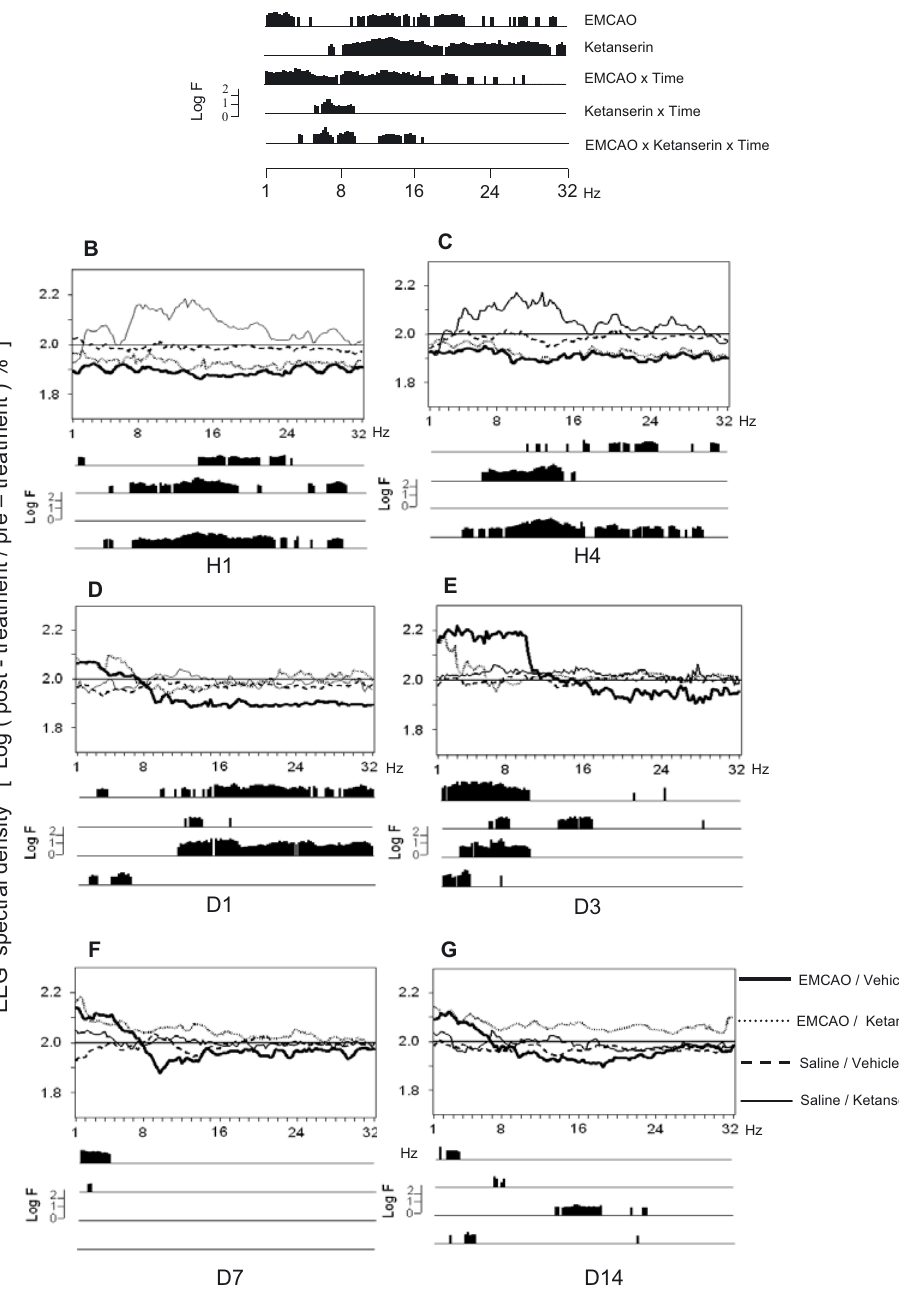
Figure 1. Effects of intracerebral injection of ET1 (60 pmol) in the vicinity of left MCA in conscious rats on the EEG power spectra in the left somatosensory cortex, forelimb region (SIFL) during quite waking and the effects of ketanserin (6 mg/kg i.p.) administered 20 min after ET1. At A – MANOVA results for each 0.25 Hz-bin of the power spectra from 1 to 32 Hz expressed as log Fisher (F)-values (vertical lines). Only frequency bins where the main effects of factor “EMCAO”, factor “Ketanserin” and their interactions with factor “Time” were significant at P < 0.05 were depicted. At B, C, D, E, and F – EEG spectral profiles: EEG power density values for each bin of 0.25 Hz from 1 to 32 Hz expressed as percentage of the corresponding values before treatment (or combination of treatments) and plotted on a logarithmic scale. The horizontal line at 2.0 represents the corresponding pre-treatment values taken as 100%; H1, H4, D1, D3, D7, and D14 are time sessions after treatments as follows: 1h; 4h; day 1; day 3; day 7; day 14. Four horizontal lines with vertical bars below each group of EEG spectral profiles at B, C, D, E, and F indicate those frequency bins where statistical significance was achieved in comparisons between each pair of the four conditions (from top to bottom): EMCAO/Vehicle vs. Saline/Vehicle, Saline/Ketanserin vs. Saline/Vehicle; EMCAO/Vehicle vs. EMCAO/ketanserin, and EMCAO/Ketanserin vs. Saline/Ketanserin (The bars are log-transformed Fisher’s PLSD comparisons, p <